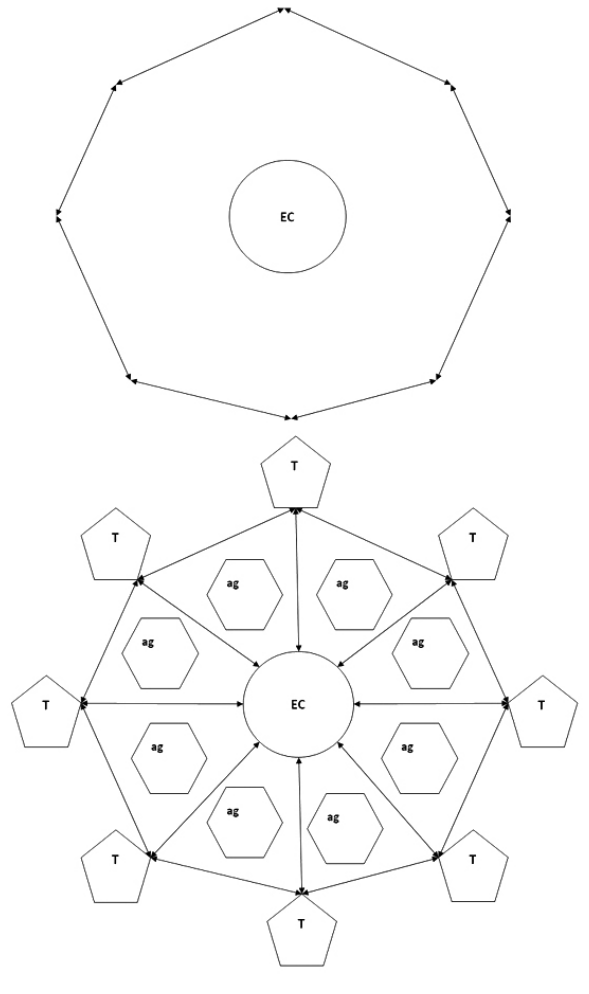
Fig. 1 . (a). Flowchart of internal structural relations